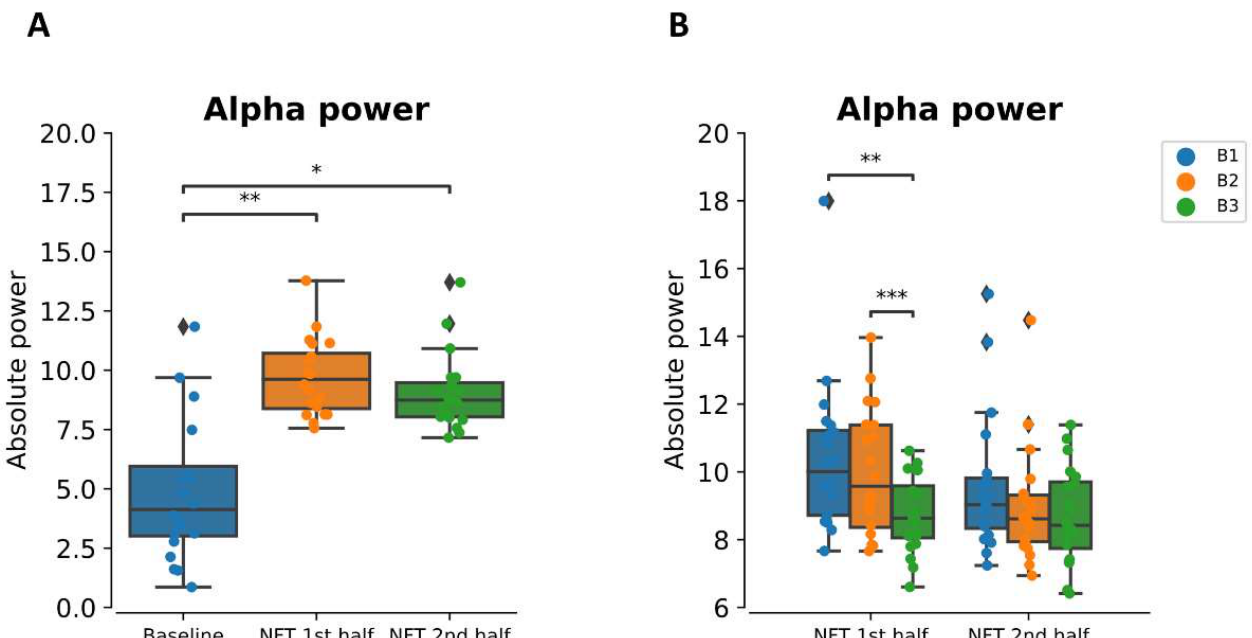
Figure 6. ( A ) Absolute alpha power at baseline and within-session (1st half = first 15 min, 2nd half = last 15 min) and ( B ) at within-session (first half and second half) sub-blocks (B1, B2, and B3 each five minutes). * p < 0.05, ** p < 0.001, *** p < 0.0001.